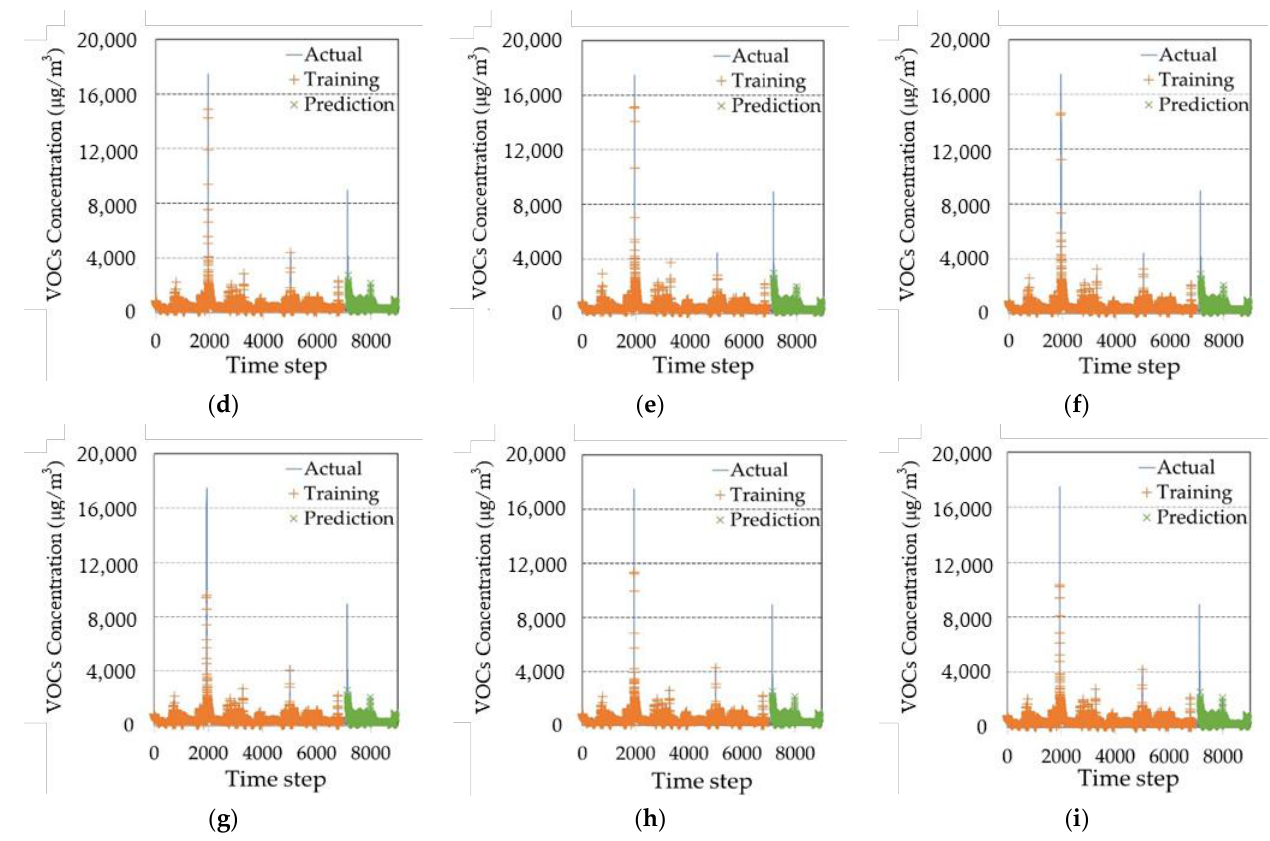
Figure 7. Prediction results of VOCs concentration. ( a ) LM-Hidden layer-1; ( b ) LM-Hidden layer-3; ( c ) LM-Hidden layer-5; ( d ) BR-Hidden layer-1; ( e ) BR-Hidden layer-3; ( f ) BR-Hidden layer-5; ( g ) BFG-Hidden layer-1; ( h ) BFG-Hidden layer-3; ( i ) BFG-Hidden layer-5. Table 5. CV(RMSE) and MBE of VOCs concentration prediction